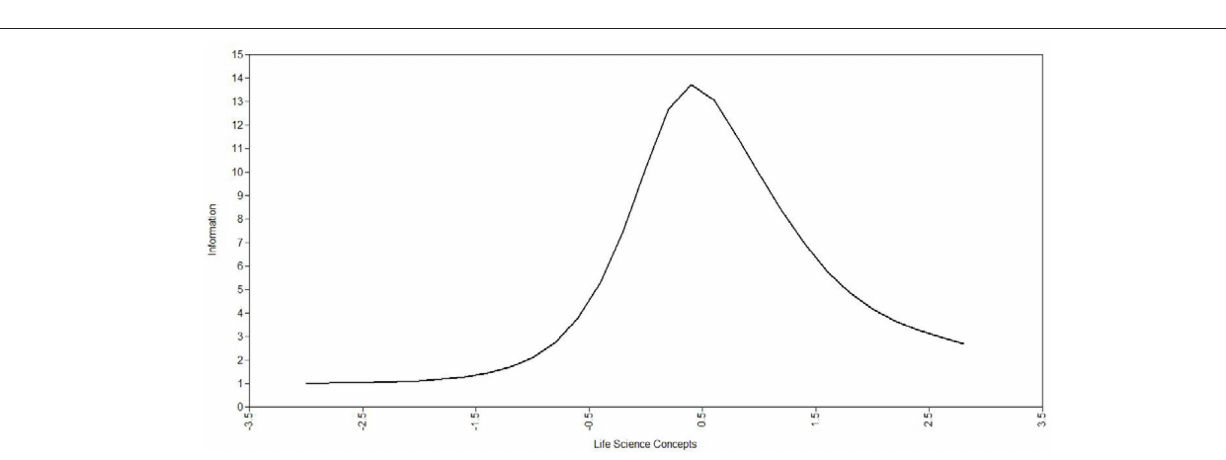
FIGURE 3 | SLA information function for the Life Science Concepts dimension.